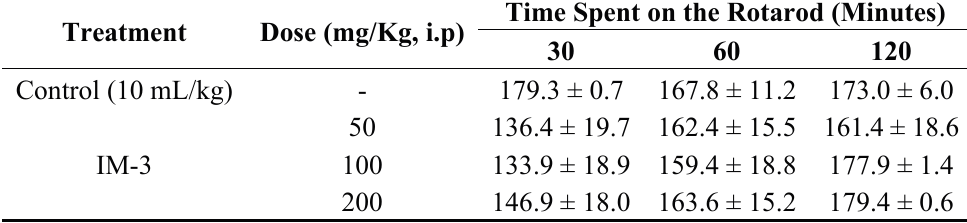
Table 1. Effect of 3-phenyl-5-(4-ethylphenyl)-imidazolidine-2,4-dione (IM-3) on the rotarod test in